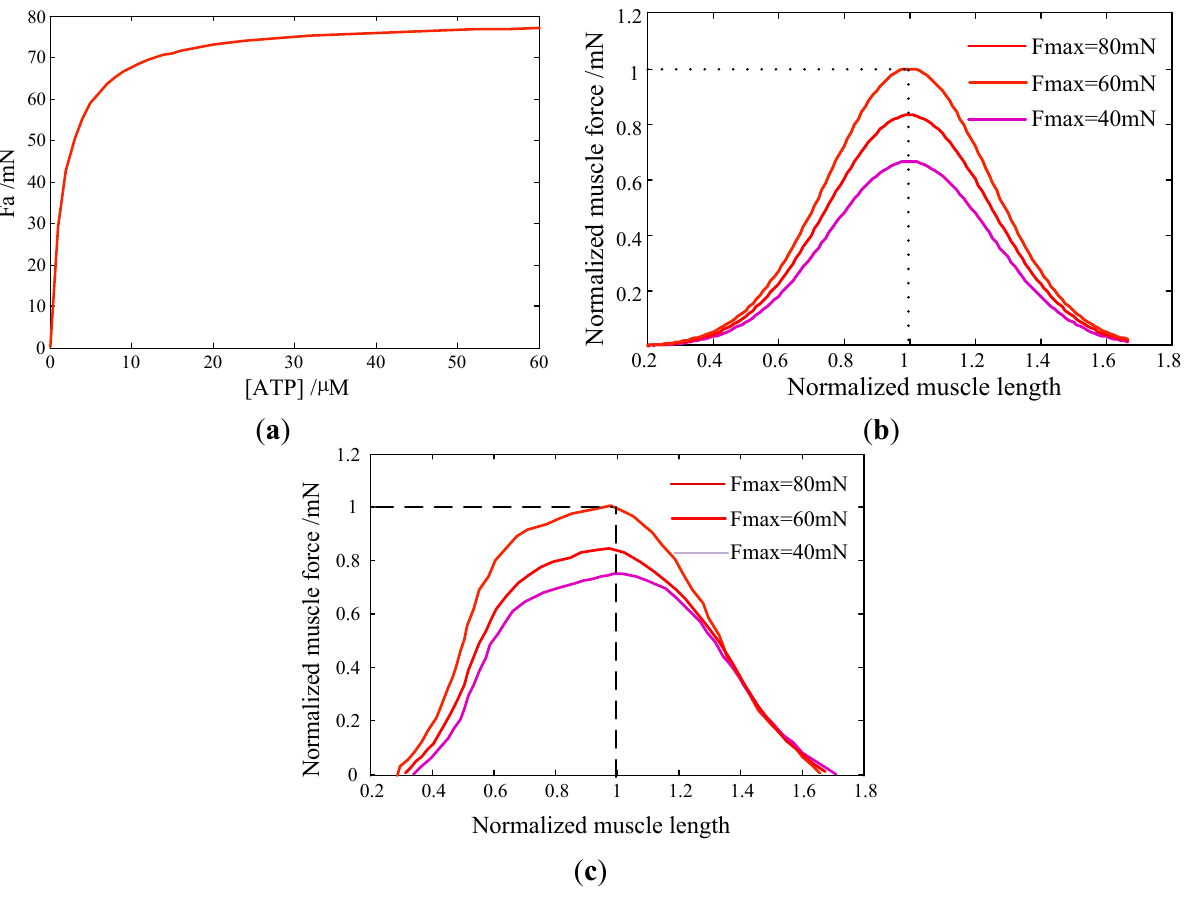
Figure 4. ( a ) The relationship between active contraction force and [ATP]; Active force-length curves, normalized by the maximum muscle force and optimal fiber length, respectively, calculated from either our model ( b ) or the Hill model ( c